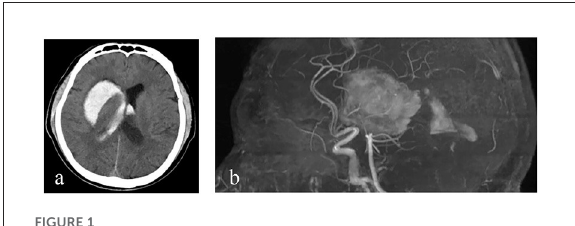
FIGURE1 Imaging findings. (a, b) Cranial CT and cranial MRA show an intracerebral hemorrhage in the right basal ganglia and in bilateral lateral ventricles.